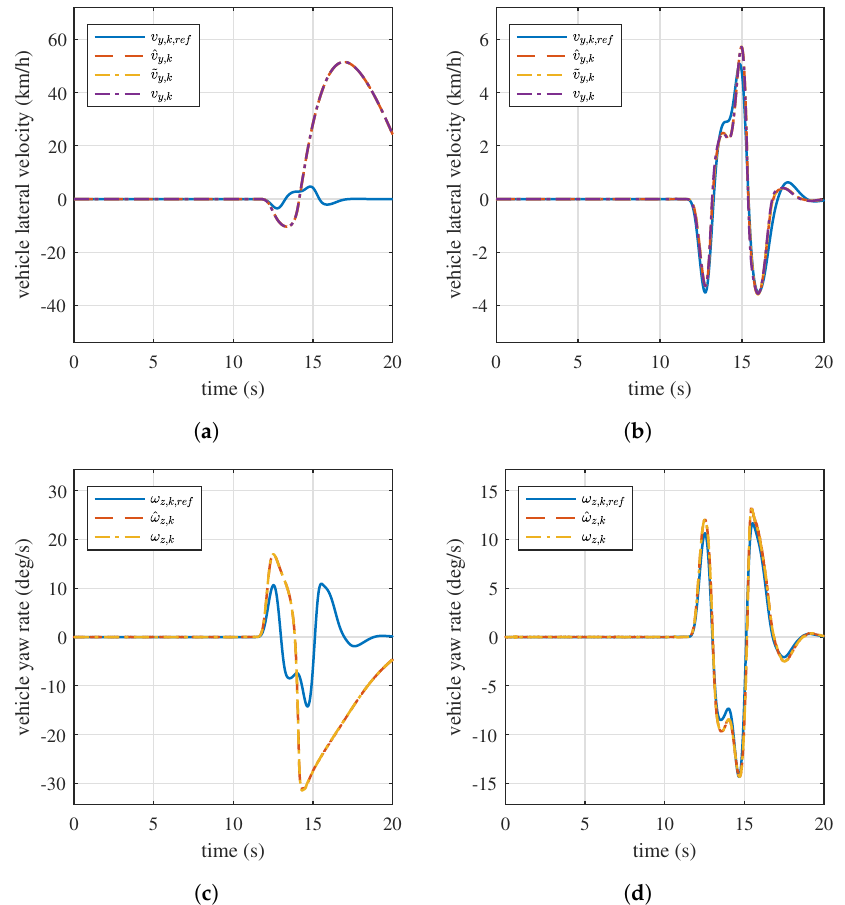
Figure 9. Open–loop versus closed–loop system comparison in terms of vehicle lateral velocity v y , k and yaw rate ω z , k . ( a ) Open–loop system. ( b ) Closed–loop system. ( c ) Open–loop system. ( d ) Closed–loop